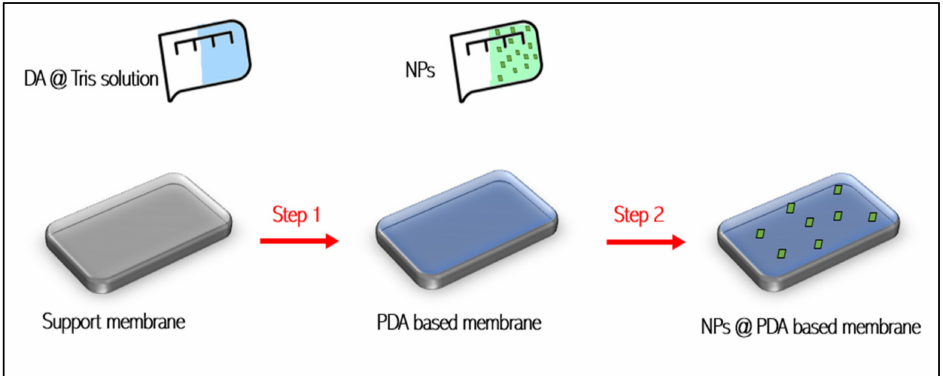
Figure 2. Two-step modification